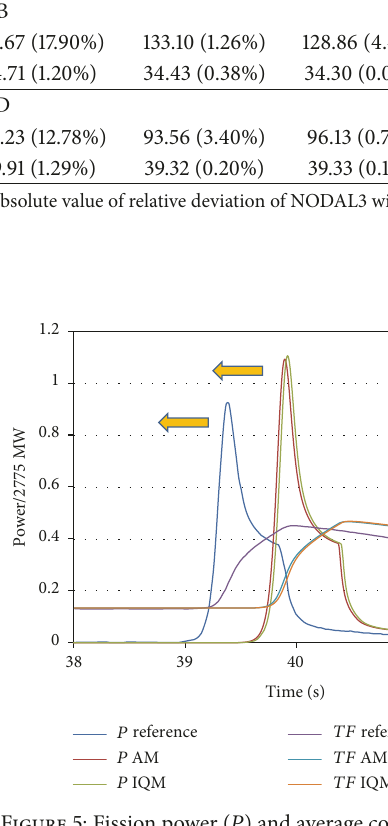
reference, PANTHER code, used the 3 × 3 nodes and 48 nodes for radial and axial, respectively [12], so the increment of axial nodes in NODAL3 calculations, 18 nodes (1 × 18) to 36 nodes (2 × 18), give closer result to the